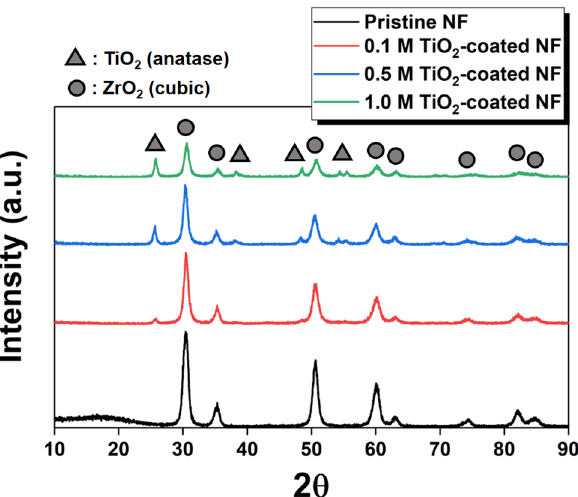
Figure 3. XRD diffractogram of YSZ/silica (pristine) and TiO 2 -coated YSZ/silica NF (0.1, 0.5 and 1.0 M TiO 2 - coated NF).